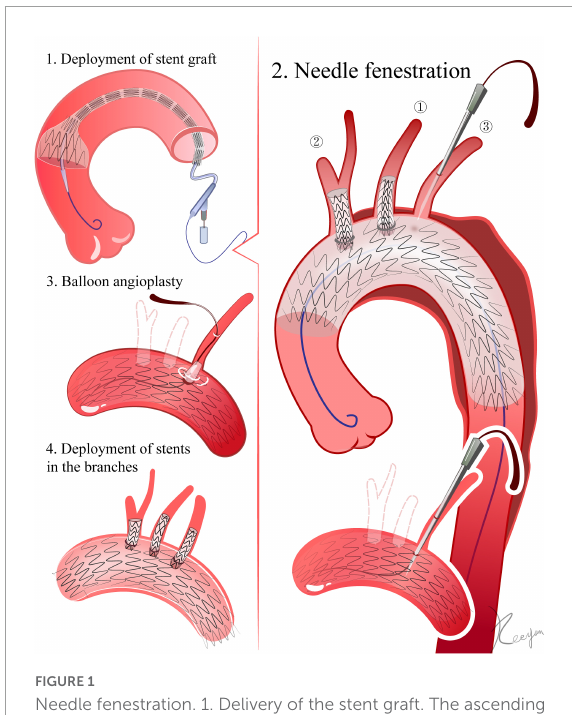
FIGURE2 Laser-assisted fenestration. 1. Delivery of the stent graft. The ascending aorta is the landing zone for fenestrations of all super-aortic stents. 2. Laser-assisted fenestration. In LSA, for example, an angle-adjustable sheath is advanced until its